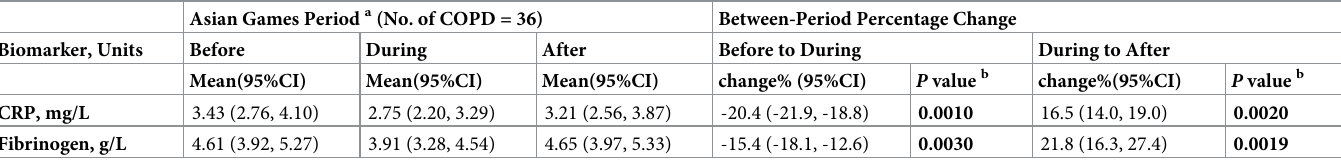
Table 4. Biomarker concentrations by period and between-period change in participant-specific biomarker concentrations in COPD patients. Asian Games Period a (No. of COPD = 36) Between-Period Percentage Change Biomarker, Units Before During After Before to During During to After